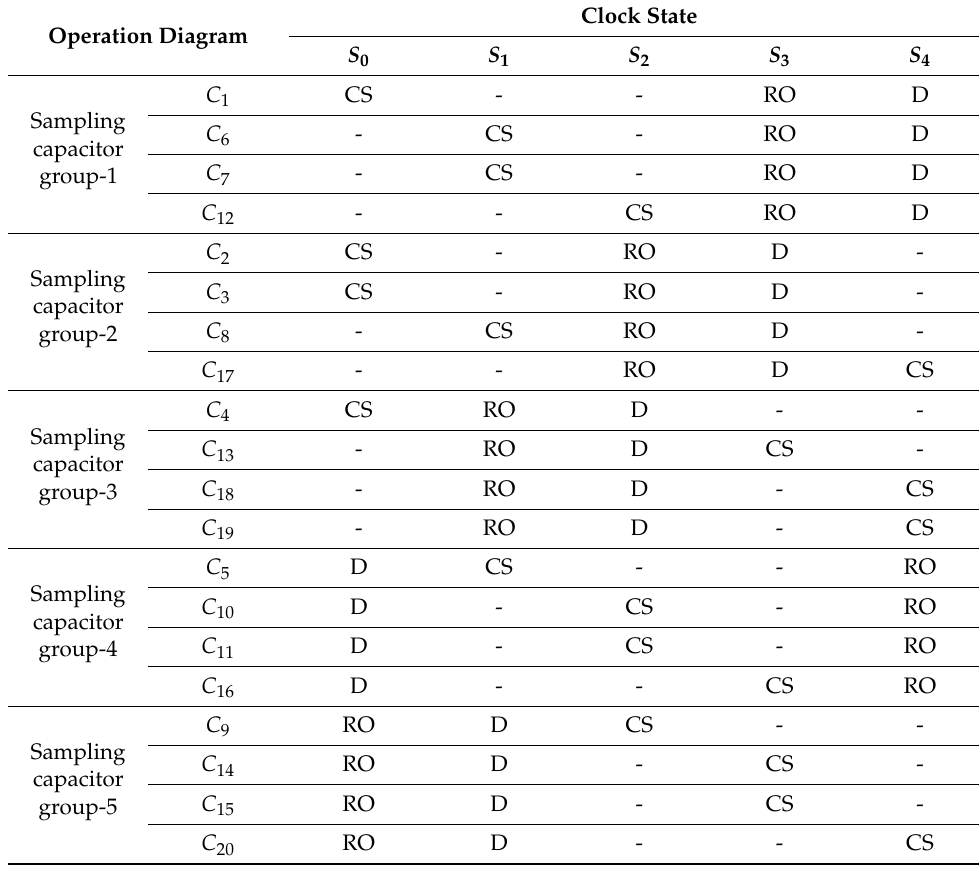
Table 1. Operation diagram of the conventional architecture for the input sample weights of {1,2,1}. CS, RO, and D stand for charge sampling, read-out, and discharging,